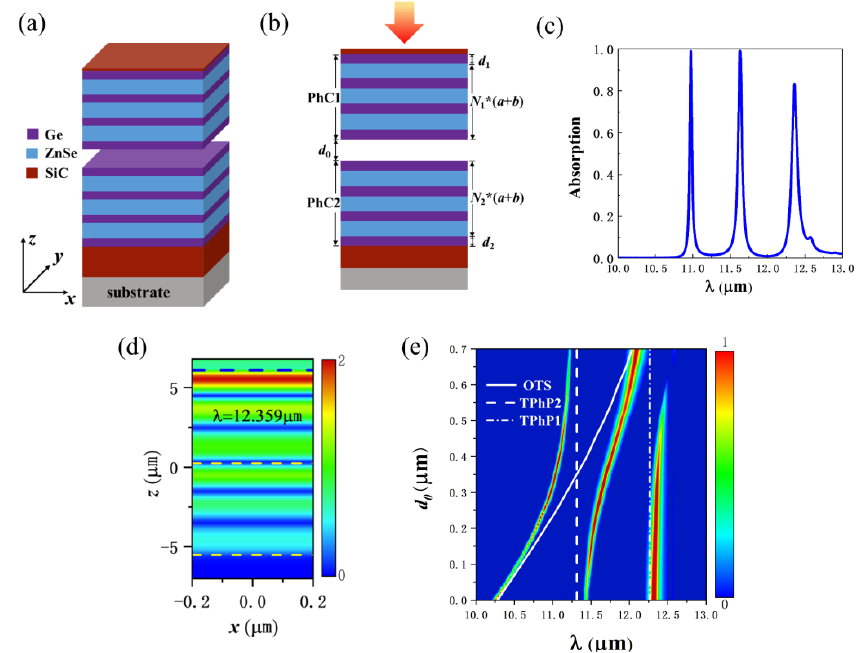
Figure 4. ( a ) Schematic diagram of the structure of SiC-PhC heterostructure-SiC structure. N 1 *( a+b ) and N 2 *( a+b ) indicate that the number of periodic layers of PhC is N 1 and N 2 , respectively. ( b ) Side view of the structure. ( c ) The absorption spectrum of SiC-PhC heterostructure-SiC structure (d 0 = 0.3 μm) . ( d ) The electric field intensity distribution at 12.359 μm. ( e ) The absorption spectra of SiC-PhC heterostructure-SiC structure as a function of d 0 .